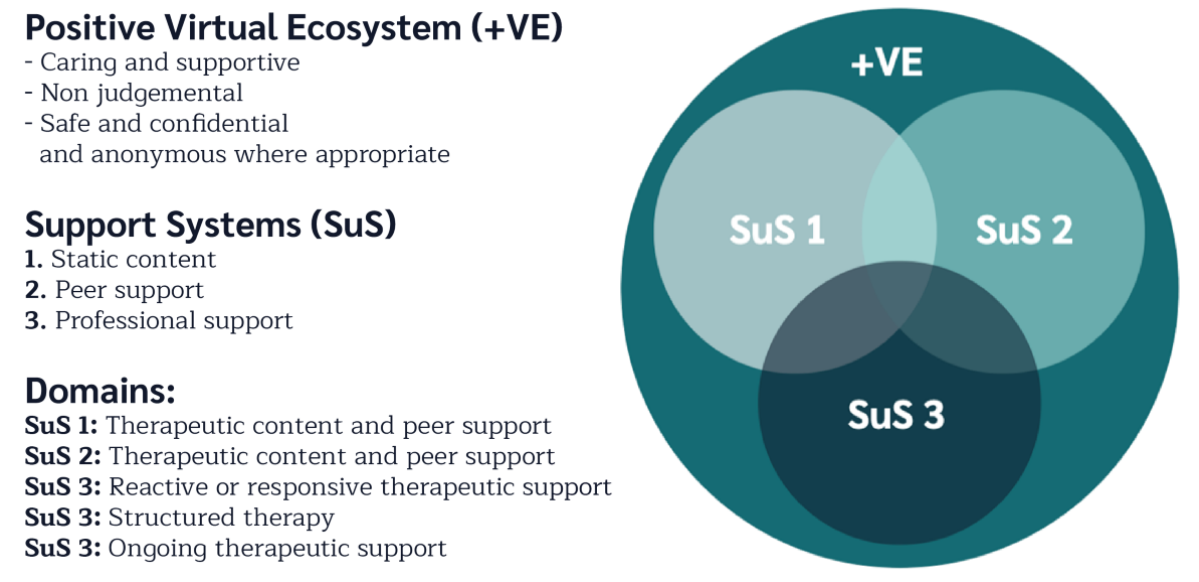
Figure 2. A positive virtual ecosystem